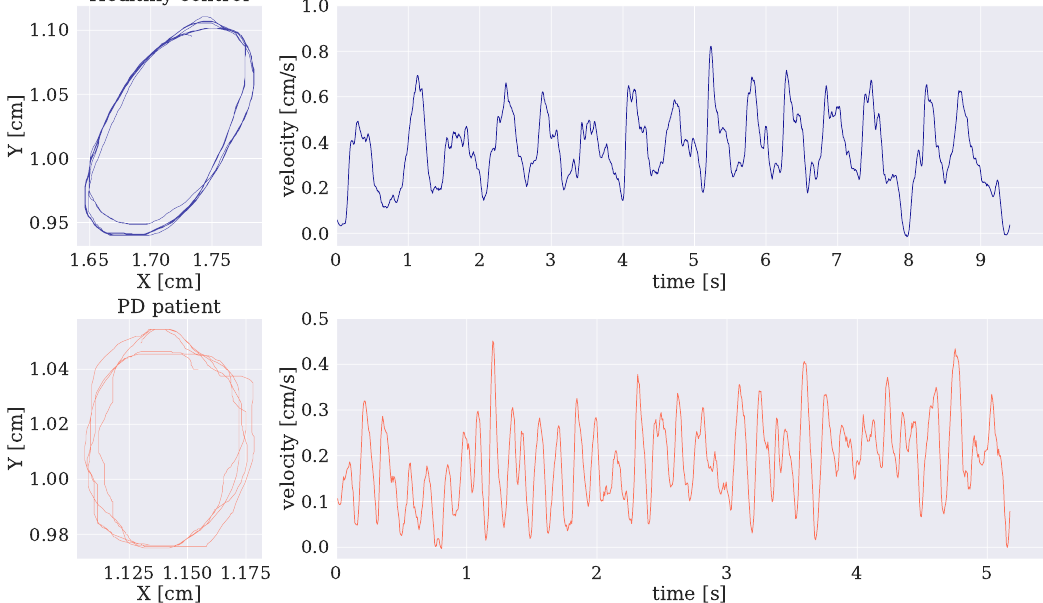
Figure 3. Handwriting samples of the repetitive loop task for HC and PD patients are on the left, and the resulting velocity profiles are on the